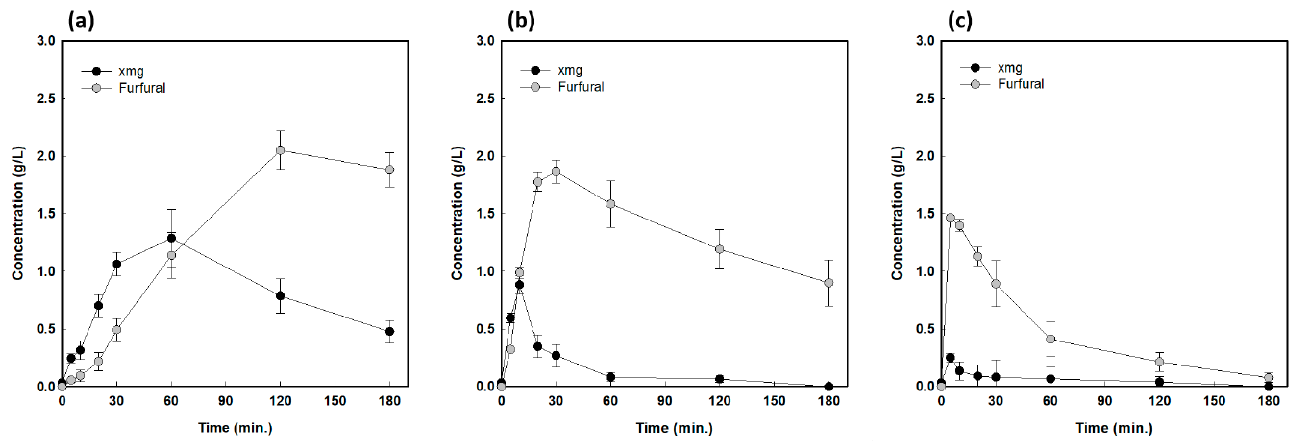
Figure 4. Furfural production and xmg generation and consumption in acidified RH hydrolysates as a function of time: ( a ) 150 °C, ( b ) 180 °C, ( c ) 210 °C.